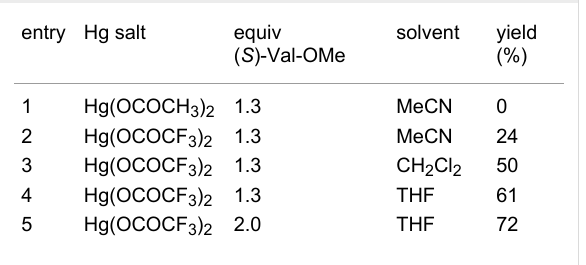
Table 1: Optimization of amidine